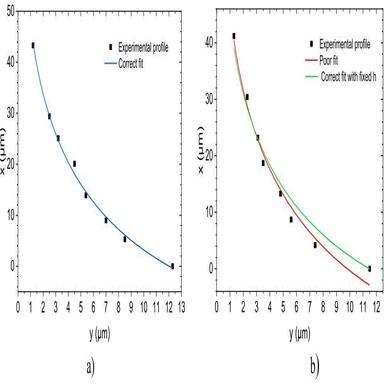
Wetting profiles of the pristine CF strand in HD. (a): profile with a correct fit. (b): the wetting profile induces divergent fitting (red curve), fixing the measured height improves the fitted values (green). (For interpretation of the references to colour in this figure legend, the reader is referred to the web version of this article.)